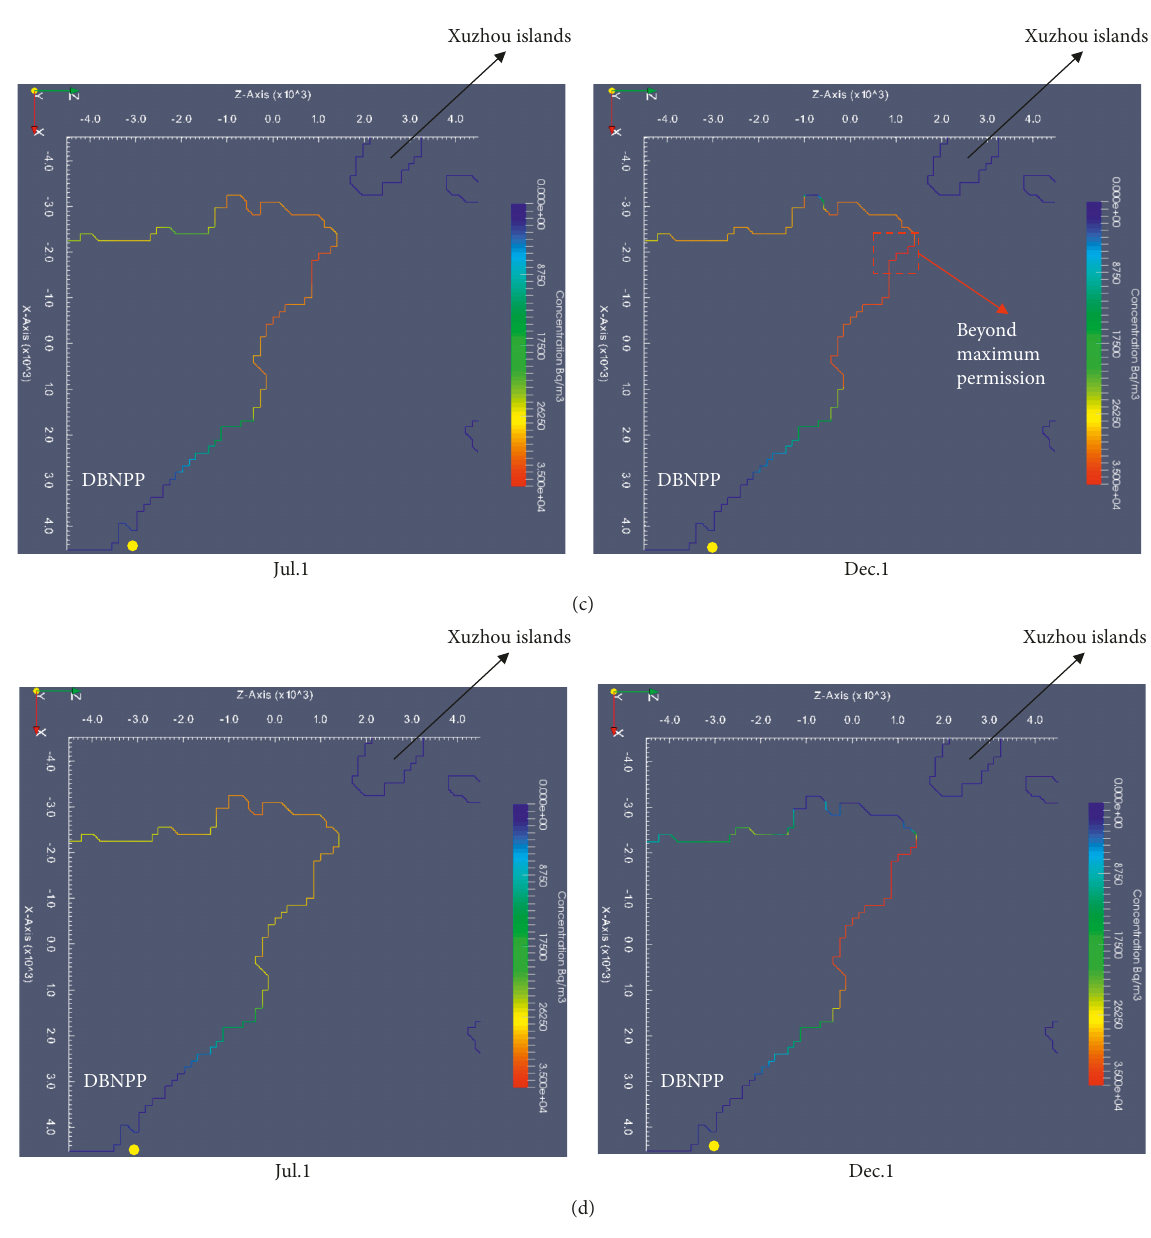
Figure 10: Maximum concentration of 137 Cs near shore in 12 hours on Jul. 1 and Dec. 1. (a) t � 1 h. (b) t � 4h. (c) t � 11 h. (d) t �